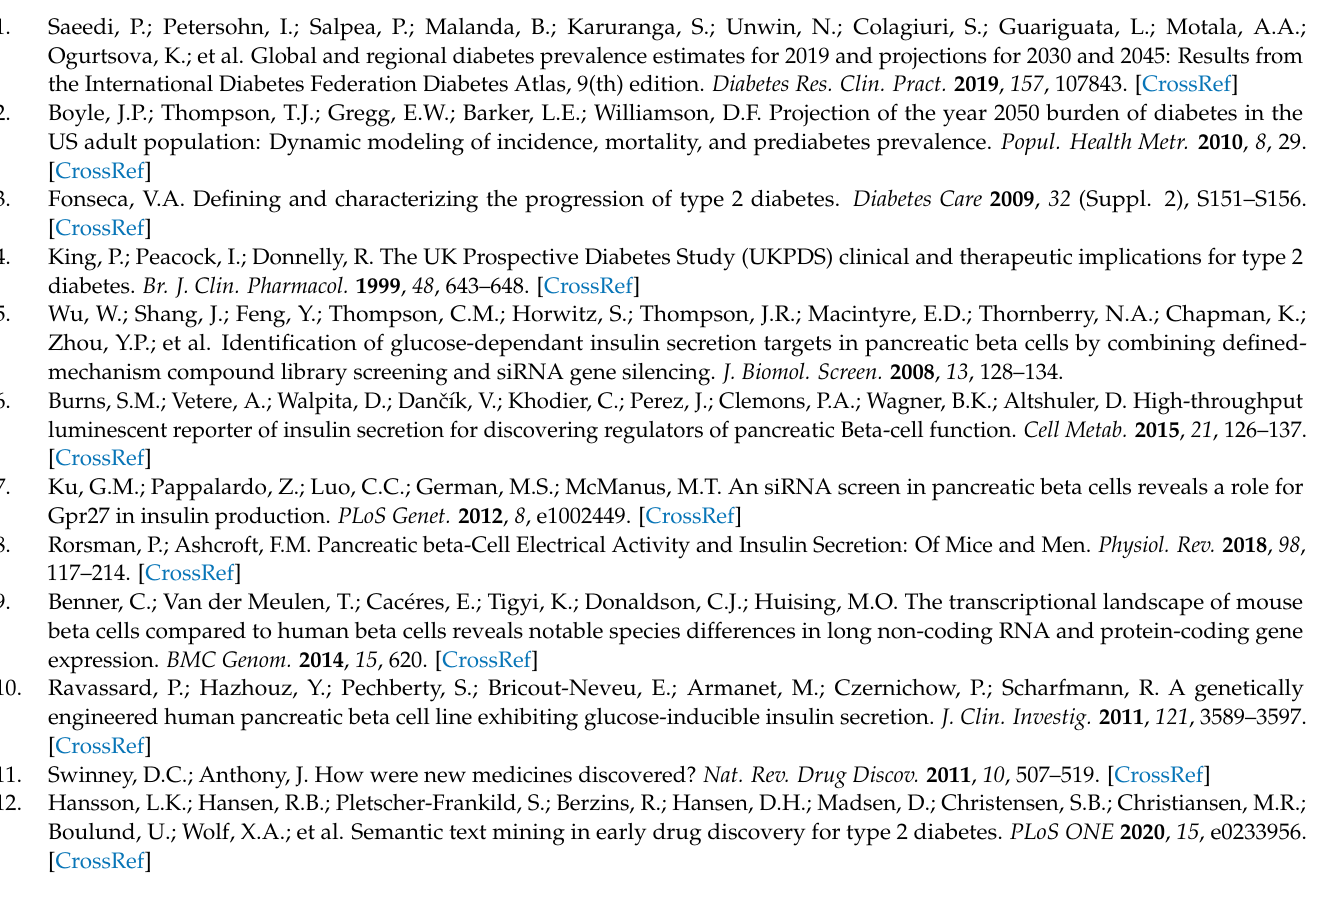
Table S1. UniProt IDs of text mining genes screened in this study; Table S2. Catalog numbers of siRNAs used in this study; Table S3: Details of the Dharmacon master siRNA library; Table S4: Assay IDs of TaqMan probes used in the study; Table S5: Hits from siRNA